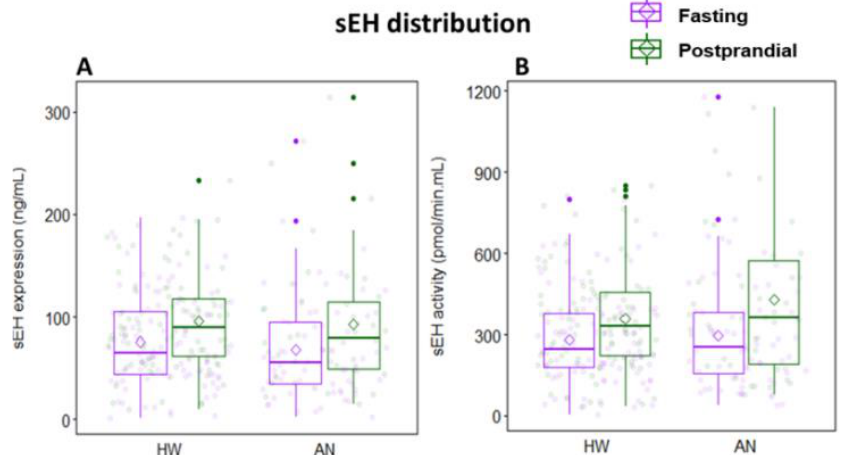
Figure 2. Distribution of ( A ) sEH expression and ( B ) sEH activity in healthy women and women with anorexia nervosa at fasting (purple) and postprandial (green) timepoints. Diamonds and colored dots represent means and individual data points, respectively. Boxplots indicate the 25th percentile, median, and 75th percentile. HW: healthy women; AN: anorexia